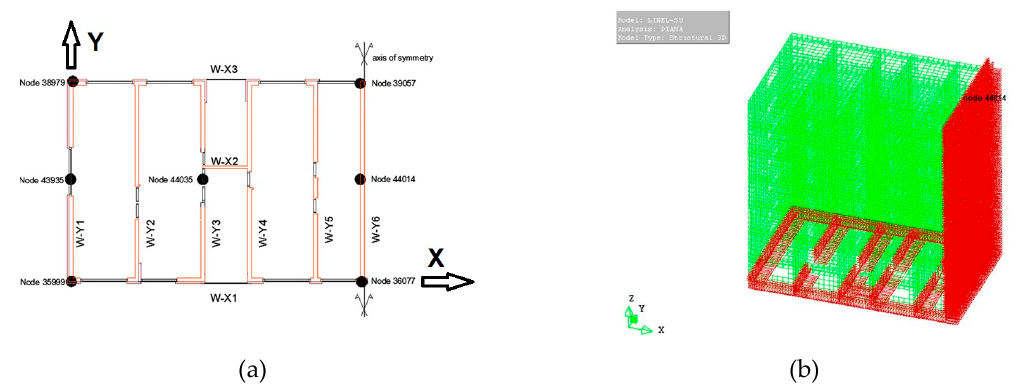
Figure 6. (a) Location of the nodes; wall labeling; (b) location of the control node